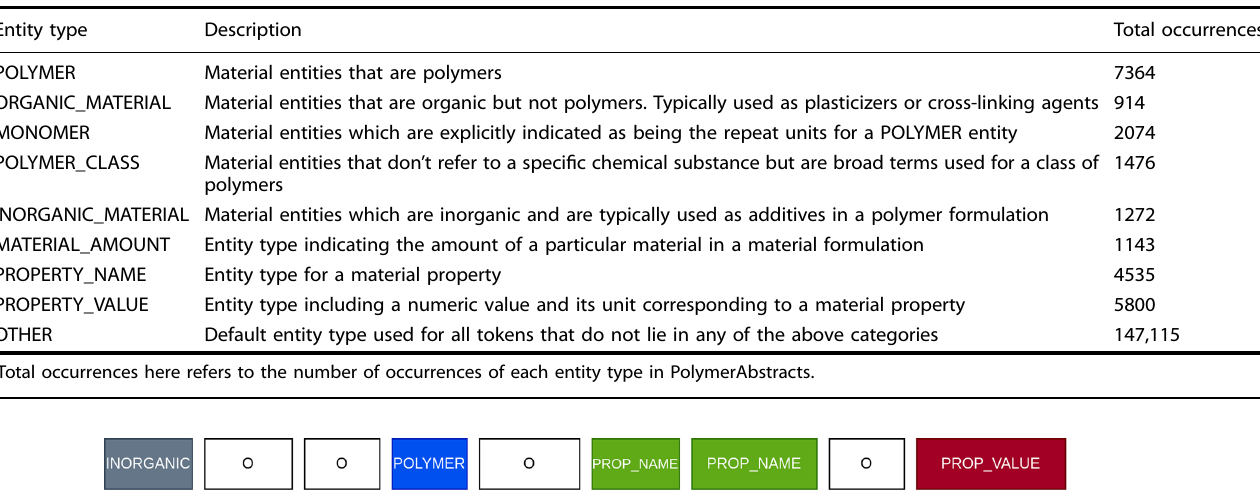
Table 1. Description of each entity type in the ontology used for annotating PolymerAbstracts.